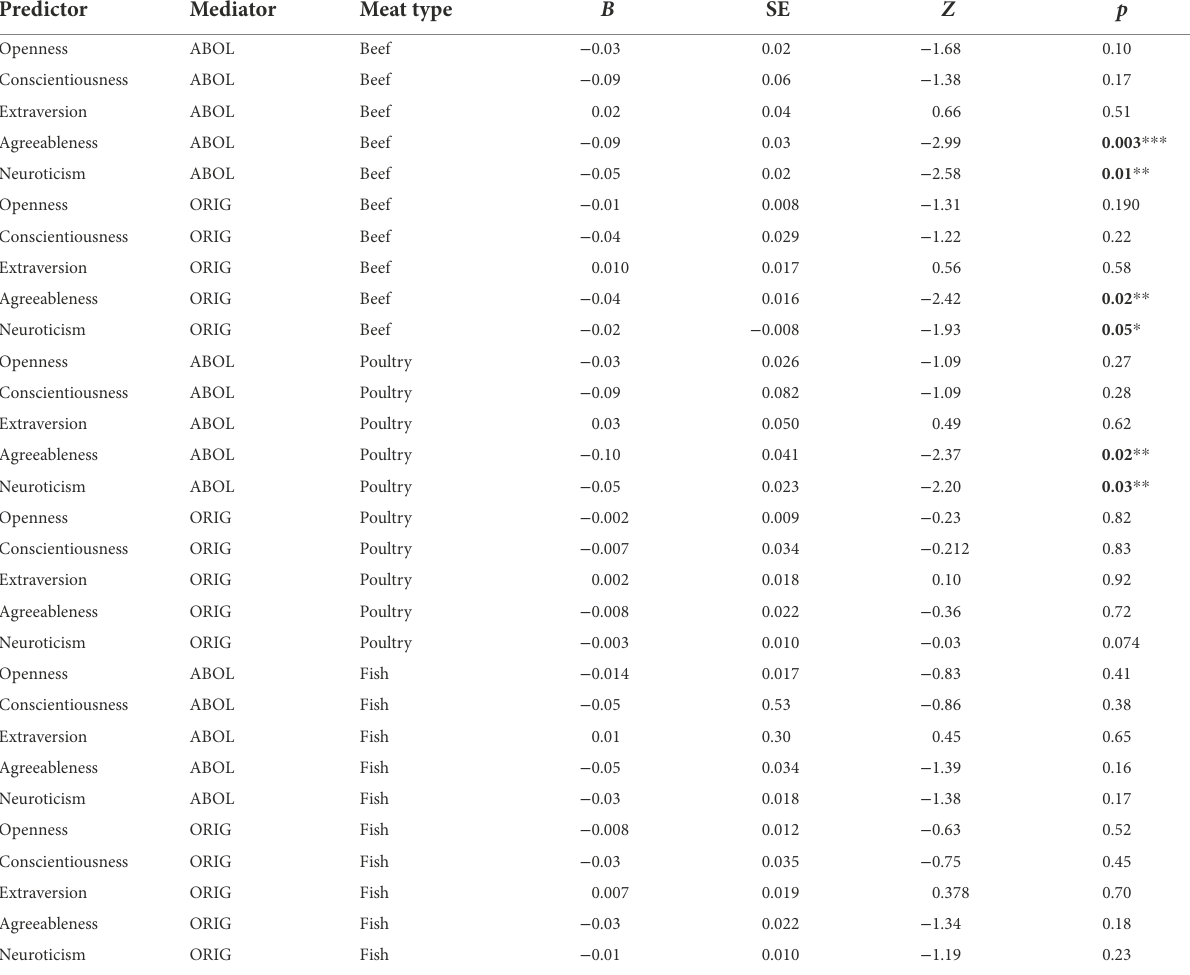
TABLE 5 Estimates of the indirect